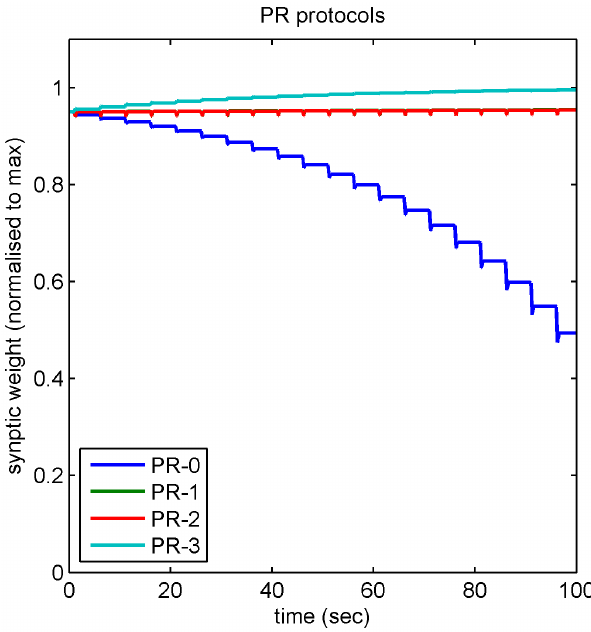
Figure 8. Effect of weight saturation on predictions for the PR protocols. Predictions for the weight changes that occur under the PR protocols shown in Fig. 7 are modified if the basic iSTDP learning rule is altered to include a model of weight saturation. Here weights have been normalised to a maximum of w ~ 1 , and the initial weight taken to be 95% of the maximum value. Normalised weight values are plotted (rather than relative weight changes as in Fig. 7) for clarity of interpretation. At each time step the weight change d w 0 predicted by the basic iSTDP rule (equation (3)) and shown in Fig. 7, has been replaced by the new rule d w ~ 1 { w ð Þ d w 0 . This rule implements a standard ‘soft’ saturation model (Gerstner and Kistler (2002), p. 385). The learning rate was chosen so that the LTD protocol PR-0 reduces the synaptic weight to 50% of its maximum value.